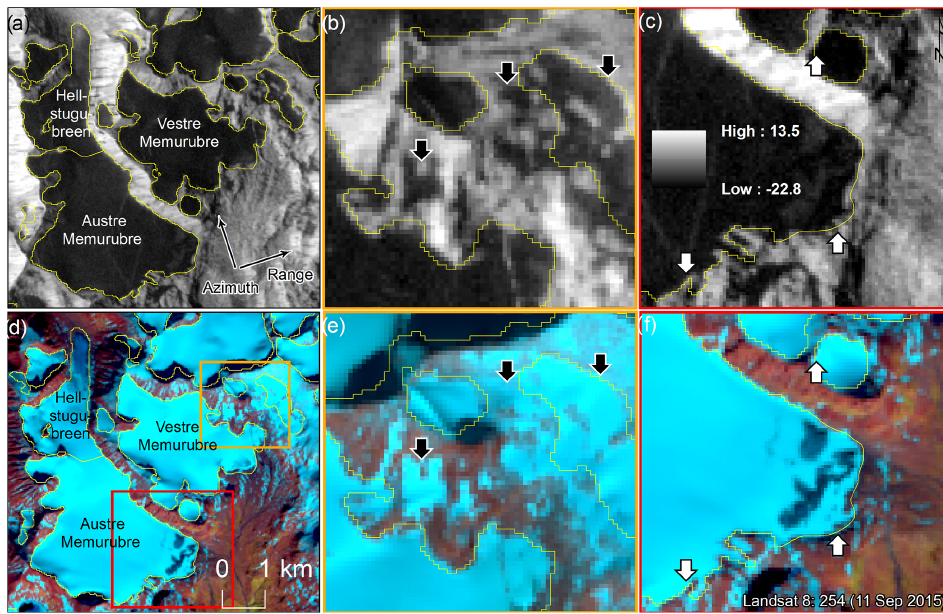
Figure 10. Glacier outline mapping for glaciers around Hellstugubreen. The inset shows zoom-in on Austre Memurubre. (a) Mean of six SAR backscatter (dB) images in the melt season from 23 July to 21 September 2015 (DOY 204 to 264). (b, c) Subsets of panel (a) as indicated by the yellow and red rectangle in panel (d) . Azimuth angle is − 18.3 ◦ . (d, e, f) Landsat 8 OLI image from 11 September 2015 (DOY 254) and subsets with poor glacier mapping conditions, since seasonal snow persisted around the glacier perimeters, and a thin layer of new snow as in panels (b) and (e) . Black arrows in panels (b) and (e) and white in panels (c) and (f) indicate places where a backscatter composite image can assist optical image when mapping glacier and perennial snow patches. Glacier outlines are from 2003 (Andreassen et al., 2008), and therefore there is some discrepancy between the imagery presented